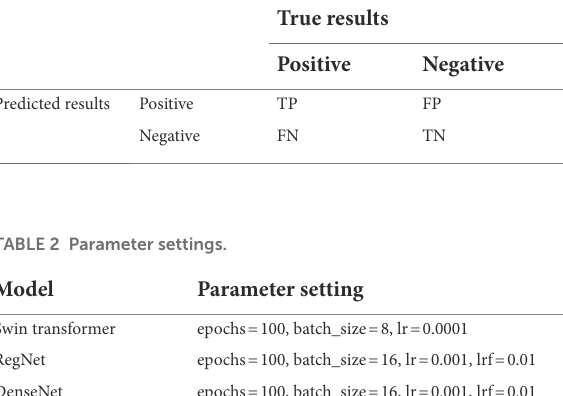
TABLE 1 The confusion matrix.